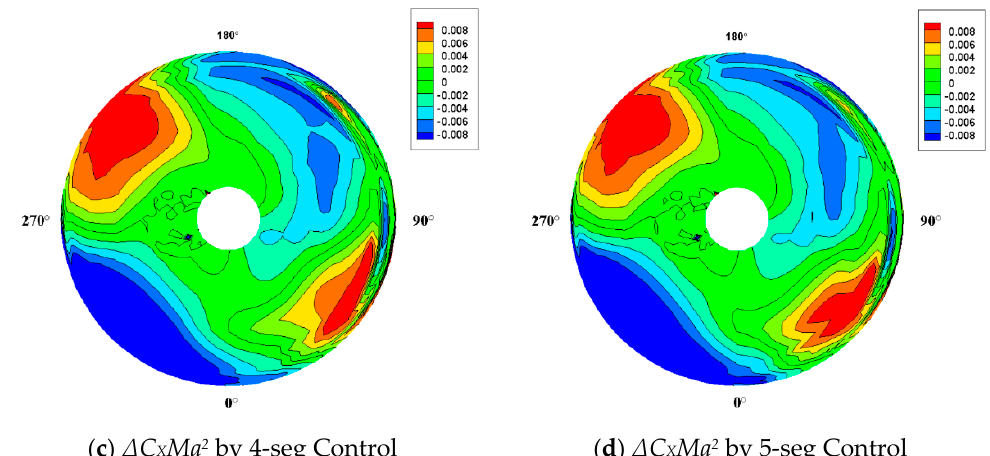
Figure 23. Dimensionless drag load increment ( ∆ C X Ma 2 ) distributions relative to the baseline rotor using the segment twist control for condition B.